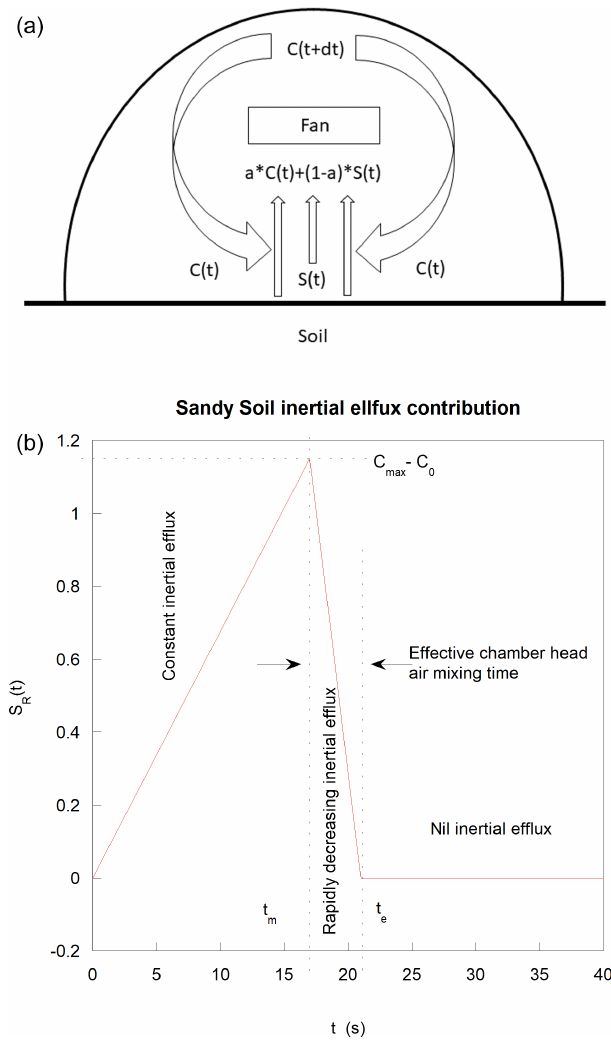
Figure 12. (a) Chamber head air mixing principle. (b) Residual wa- ter vapor efflux to the boundary layer water vapor concentration S R versus